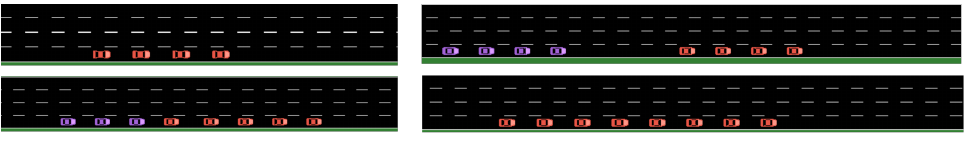
Figure 3. Merging of